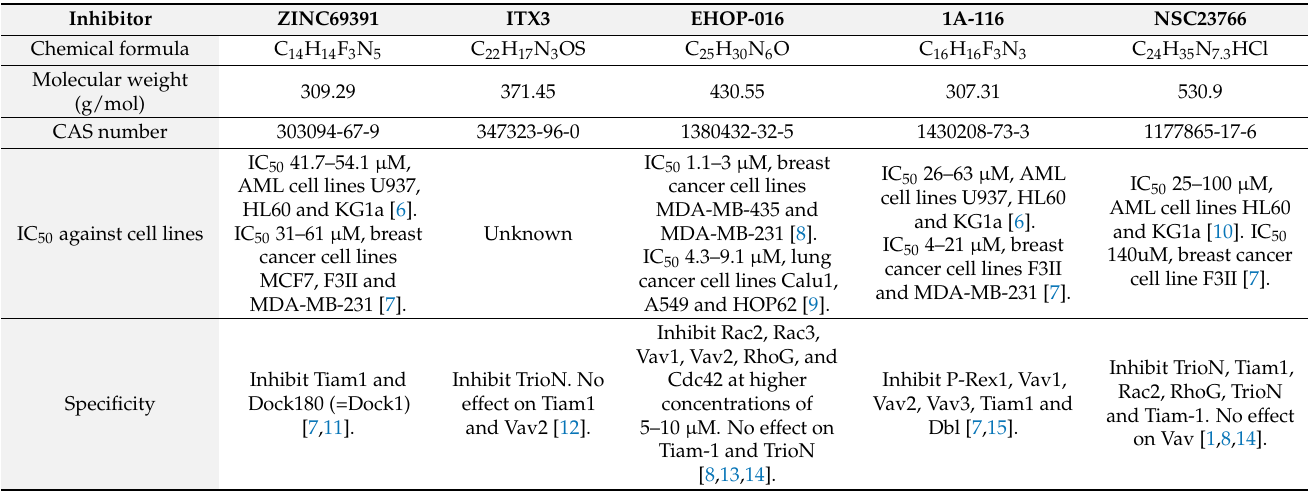
Table 2. Characteristics of the ras-related C3 botulinum toxin substrate 1 (Rac1) inhibitors used in this study. The inhibitory concentration of 50% (IC 50 ) against cell lines and specificity was found with a search for the inhibitors on PubMed. The specificity was, in general, demonstrated by Western blot studies. Tiam1, Dock180, TrioN, Vav1, Vav2 and Vav3, Dbl, and P-Rex1 are guanine exchange factors (GEFs) that activate Rac1. Rac1, Rac2, Rac3, Cdc42, and RhoG are